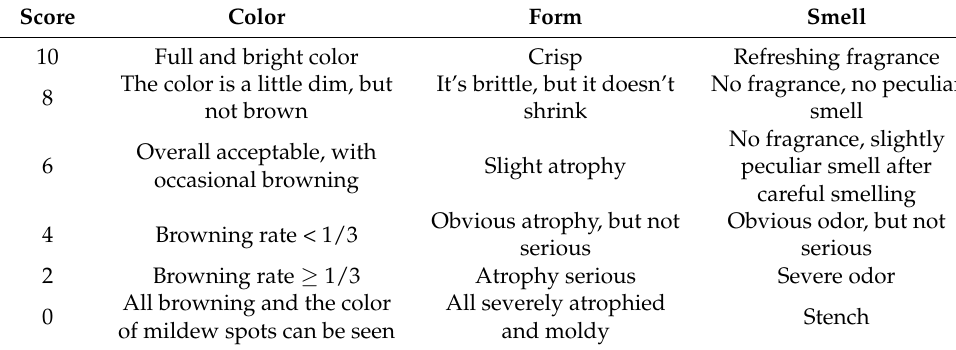
Table 2. Sensory evaluation